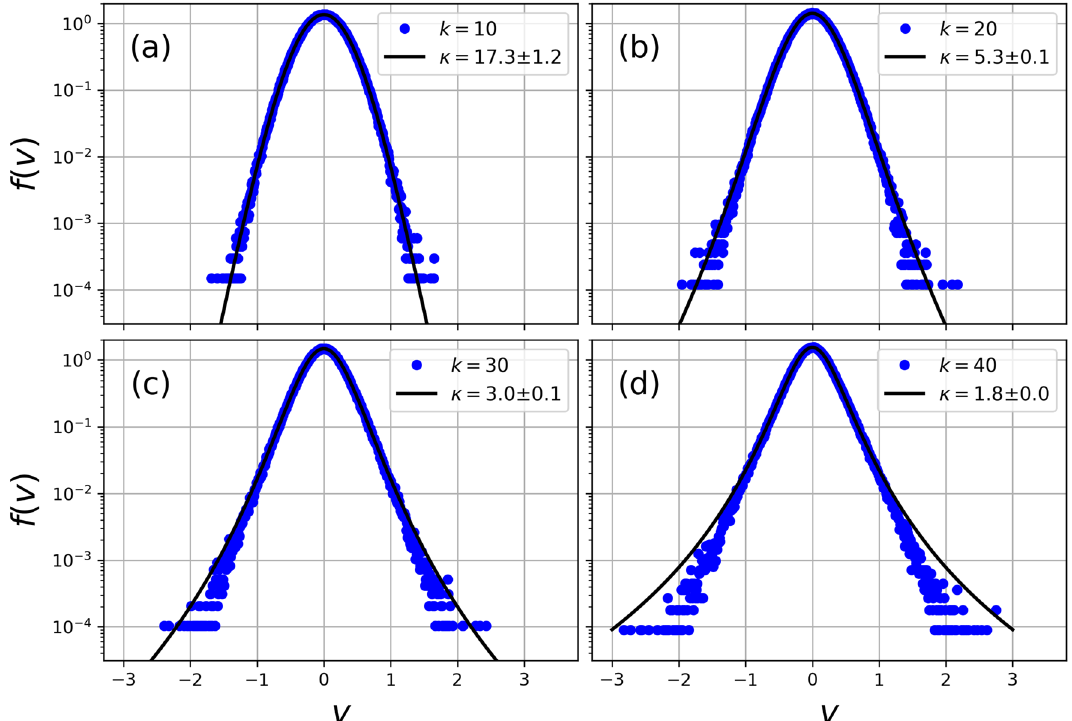
2.5 10 . − = 10 , κ 17.3 1.2 , (b) k 20 , = = ± = 40 , κ 1.8 0.0 = = ±